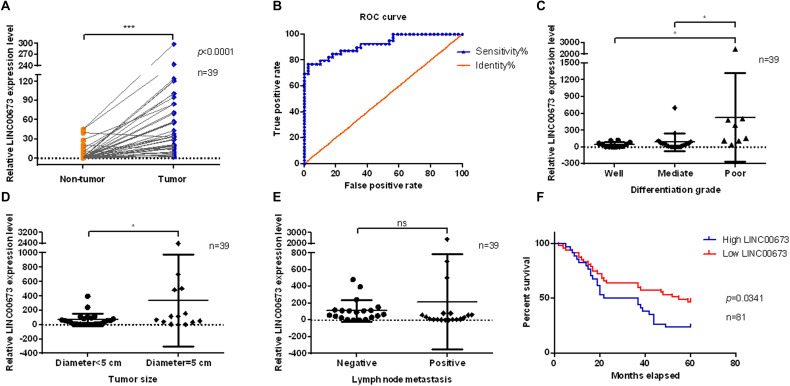
Up-regulated LINC00673 is associated with poor prognosis in esophageal squamous cell carcinoma (ESCC) patients. (A) LINC00673 expression levels were evaluated using quantitative PCR (qPCR) in 39 pairs of ESCC tissues and corresponding non-tumor tissues. ***P < 0.001 (unpaired Student’s t test). (B) Receiver operating characteristic (ROC) curve of LINC00673 in 39 ESCC patients. (C–E) Relationships between LINC00673 expression and the differentiation grade, tumor size, and lymph node metastasis, respectively. (F) Kaplan–Meier curves show the survival of ESCC patients, as grouped by the LINC00673 expression levels. *P < 0.05.